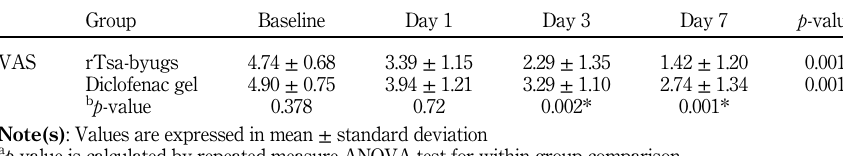
Table 3. The mean VAS in the rtsa-byugs group at baseline, day 1, 3, 7 of treatment